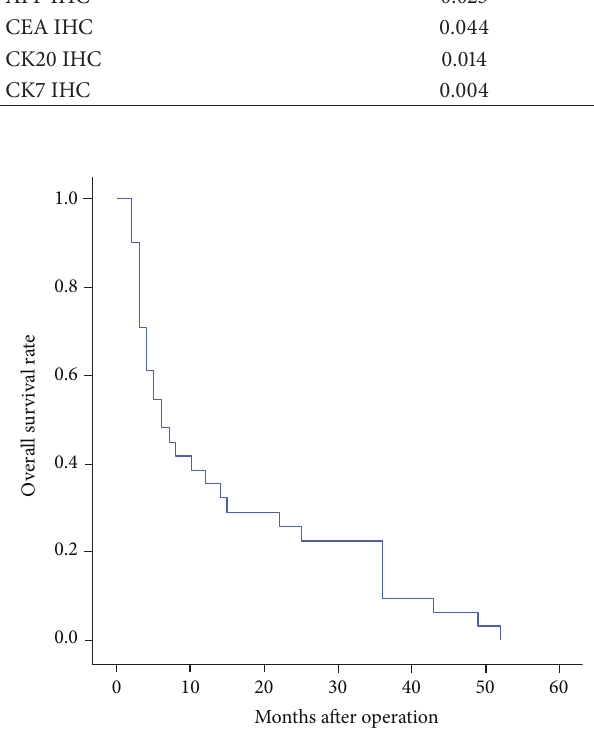
Figure 1: The overall survival of